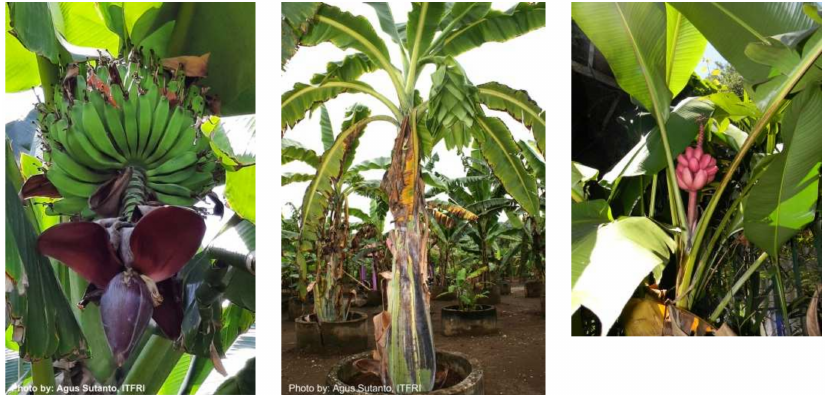
Figure 7. Banana Klutuk ( Musa balbisana colla ) with leaves used for wrapping food and Ensete glaucum , and Musa velutina for decorating ornaments